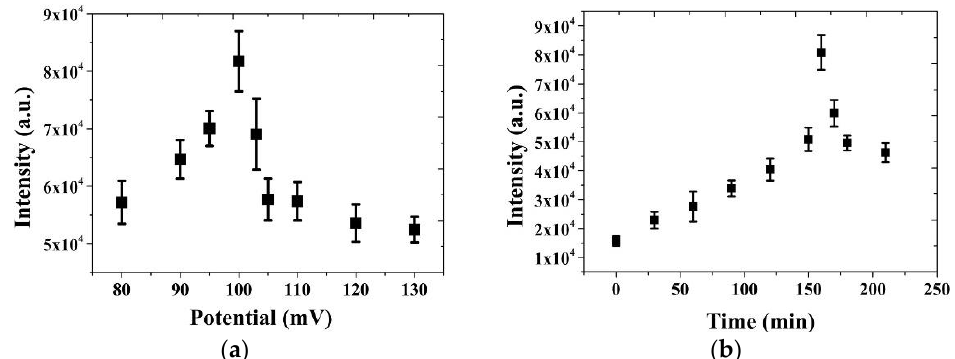
Figure 8. Electrochemical potentiostatic scan of 0.5 M glucose in 0.5 M sodium hydroxide solution. ( a ) The relationship between the Raman intensity and electric potential. ( b ) The relationship between the Raman intensity and reaction time.